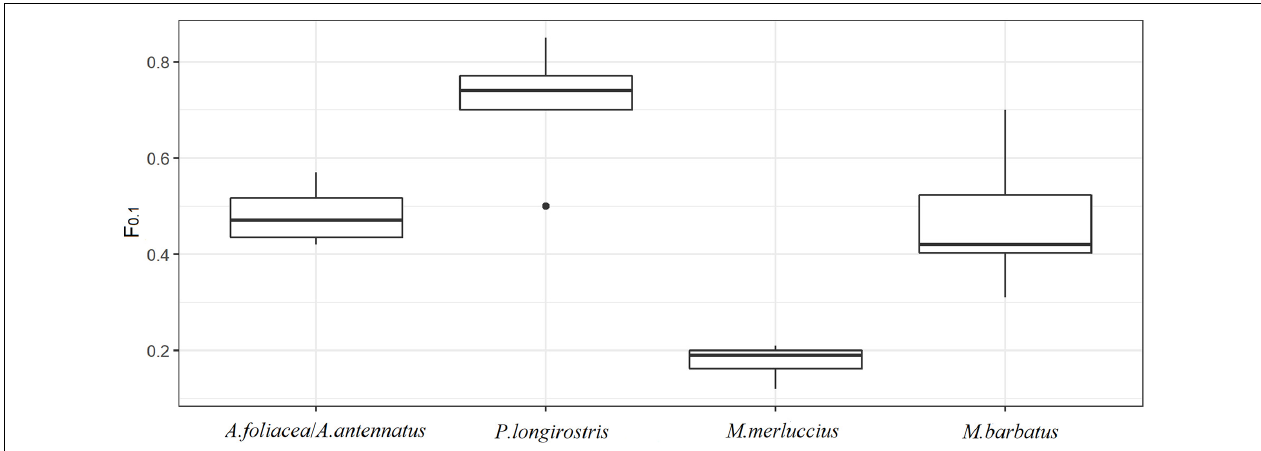
FIGURE 2 | Box plots showing the distribution of F 0 . 1 , as a precautionary proxy of F MSY , for the main target species of the Mediterranean bottom trawling. With the current exploitation pattern, achieving the F MSY of hake ( Merluccius merluccius , nine stocks) implies a strong loss of a sustainable yield of red mullet ( Mullus barbatus , 10 stocks), deep-water rose shrimp ( Parapenaeus longirostris , five stocks), and red shrimps ( Aristaeomorpha foliacea / Aristeus antennatus , four stocks) [data from Food and Agriculture Organization (FAO)